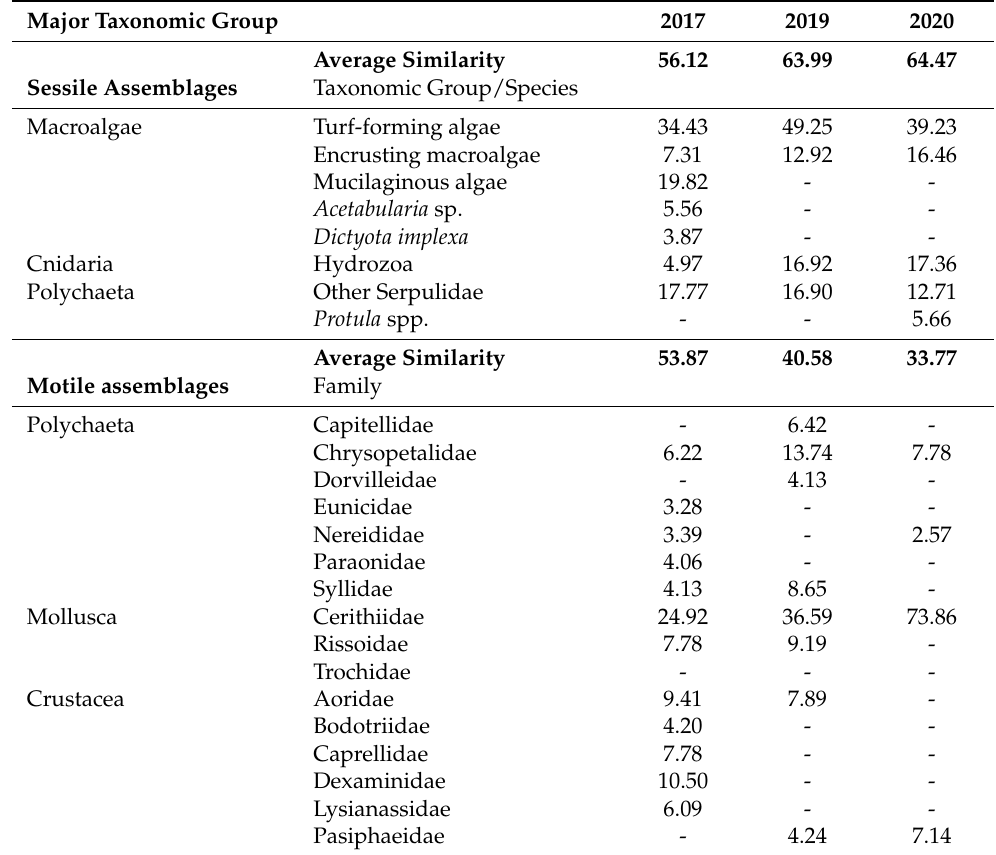
Table 2. Similarity percentage analysis (SIMPER), showing the contribution of common taxa to the average similarity (%) in each year of sampling on the artificial